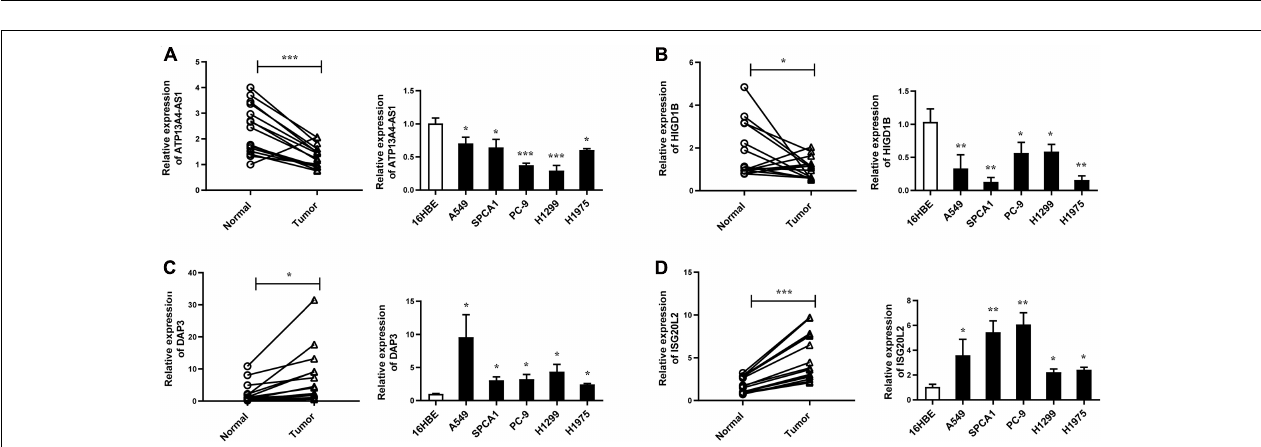
FIGURE 6 | The Kaplan–Meier plot of ATP13A4-AS1, HIGD1B, DAP3, and ISG20L2. The low expressions of ATP13A4-AS1 (A) and HIGD1B (B) were associated with high risk. The high expressions of DAP3 (C) and ISG20L2 (D) were associated with high risk.